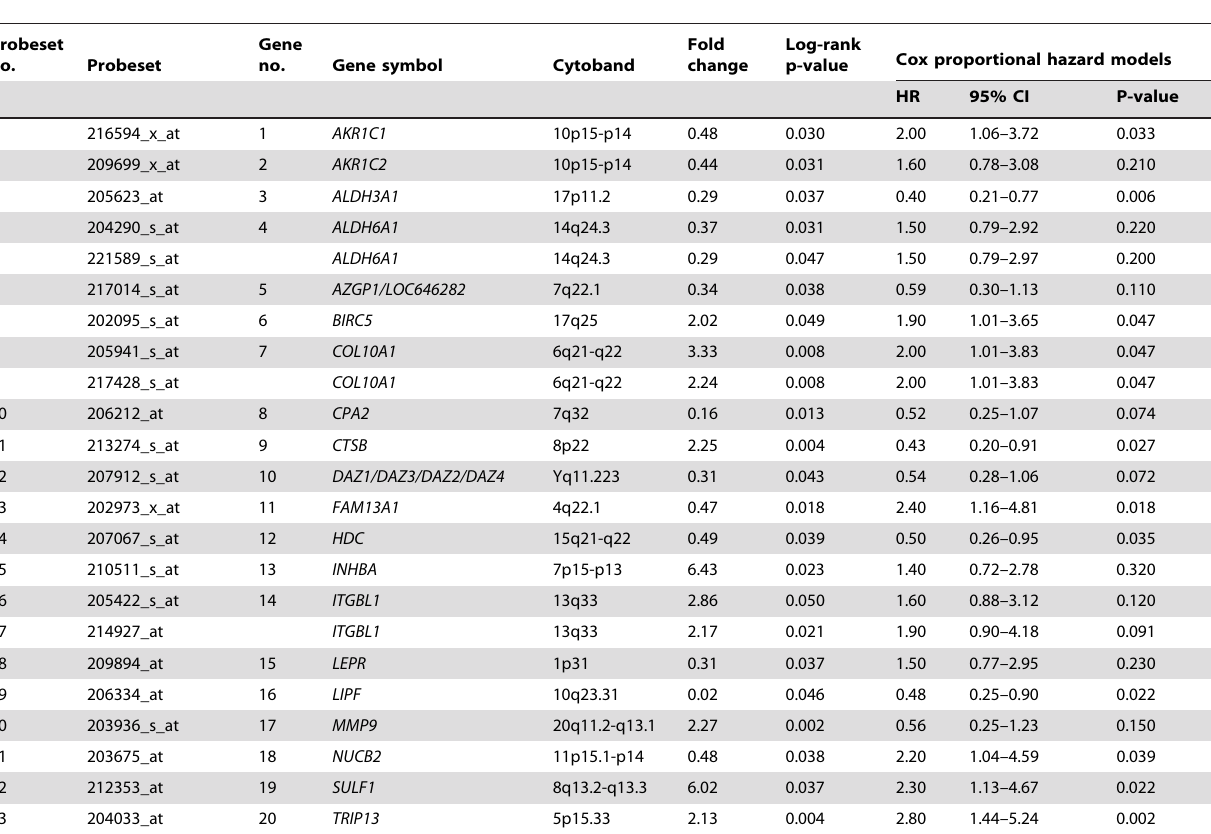
Table 2. Genes whose expression was significantly associated with survival in gastric cardia adenocarcinoma cancers (log-rank p- value , 0.05; n